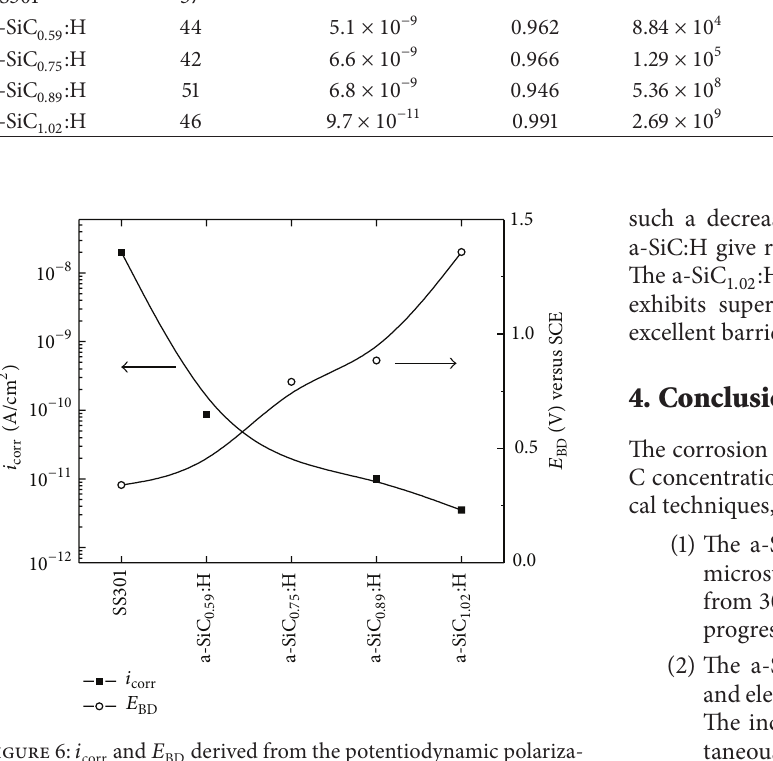
Figure 6: 𝑖 and 𝐸 derived from the potentiodynamic polariza- corr BD tion